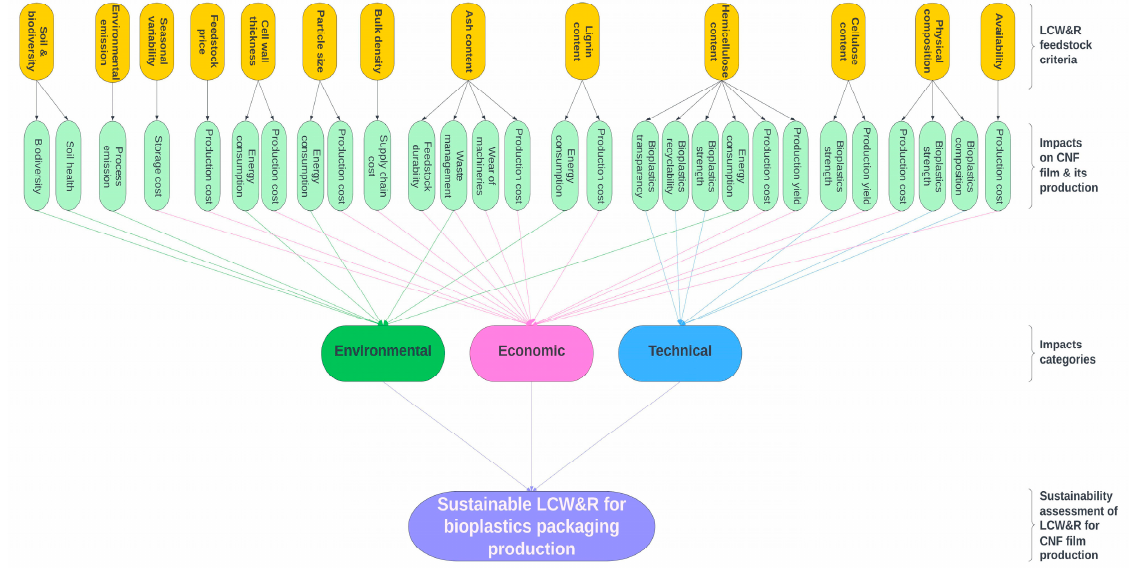
Figure 5. The thirteen feedstock criteria with impacts under technical, economic and environmental categories used for sustainability assessment of LCW&R for CNF packaging production.